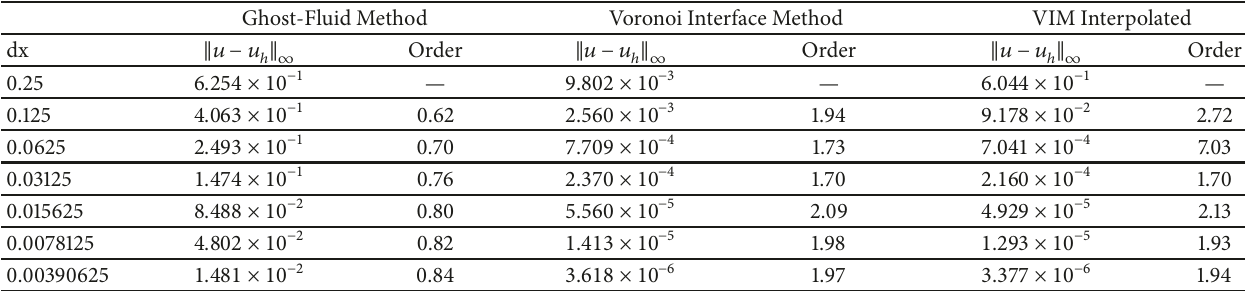
Table 5: Comparions of the 𝐿 ∞ error in the solution for the Ghost-Fluid Method and the Voronoi Interface Method, for example, shown in Section